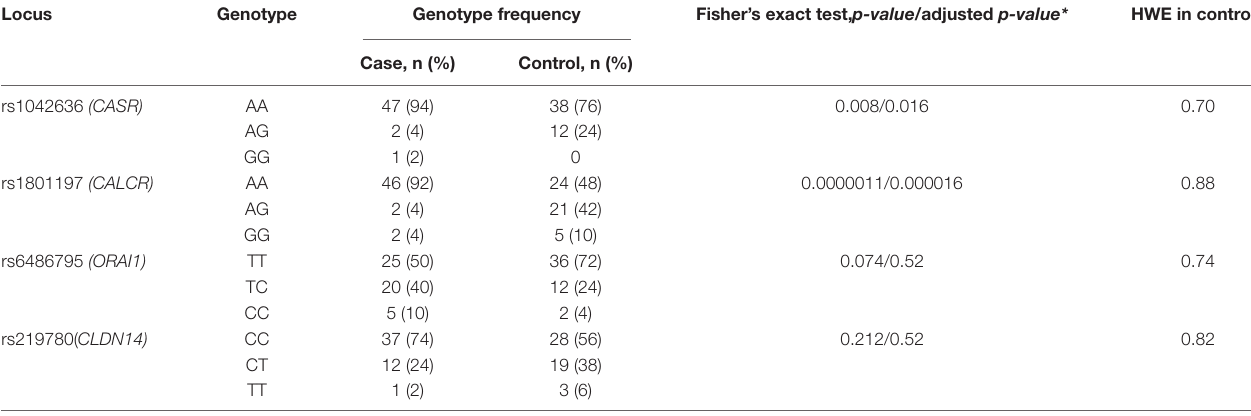
TABLE 2 | Genotypes frequencies of loci associated with KSD development in the group of patients with calcium urolithiasis and in the control group. Locus